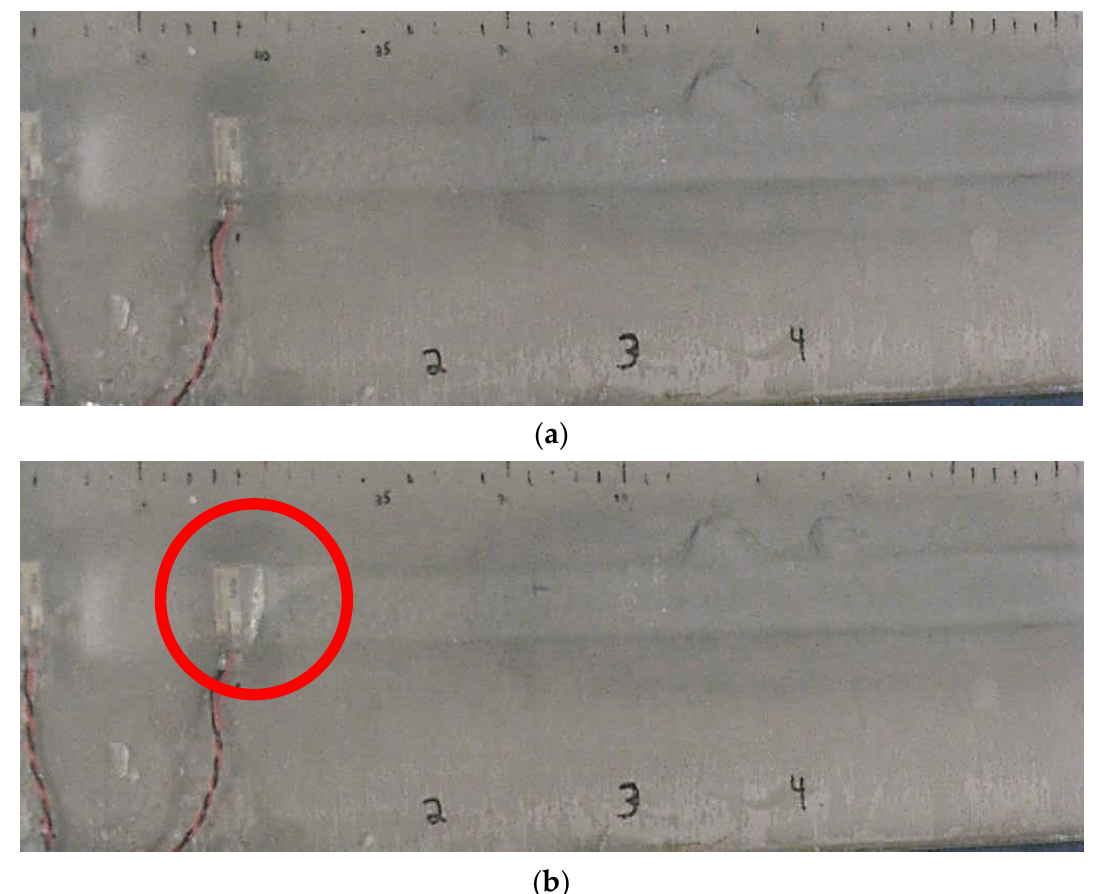
Figure 13. Pictures captured after 7.399 ( a ) and 7.466 s ( b ) with the camera during a frequency sweep from 1250 to 1500 Hz in 60 s with the five actuators activated in phase at 600 Vpp.